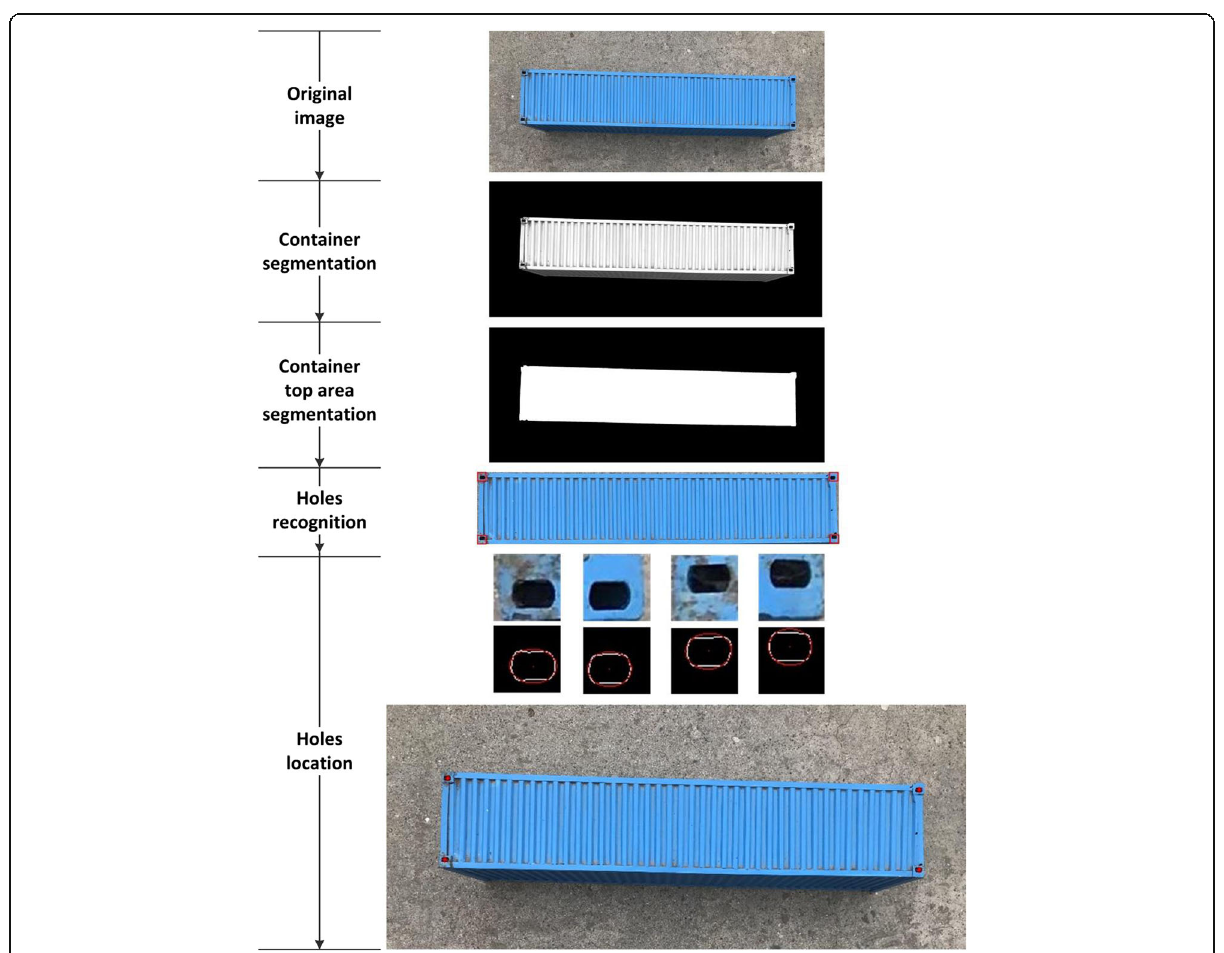
Fig. 2 The progress of the container